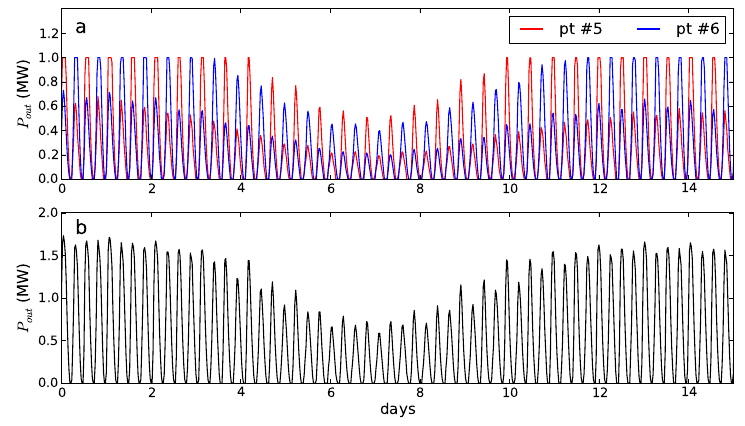
Figure 11. Cartography of potential tidal stream energy sites based on criteria Ca1-3 ( a – c ), Cb1-3 ( d – f ) (Table 1). The yellow areas represent regions matching these criteria. The red circles show the locations of Points #5 and #6.